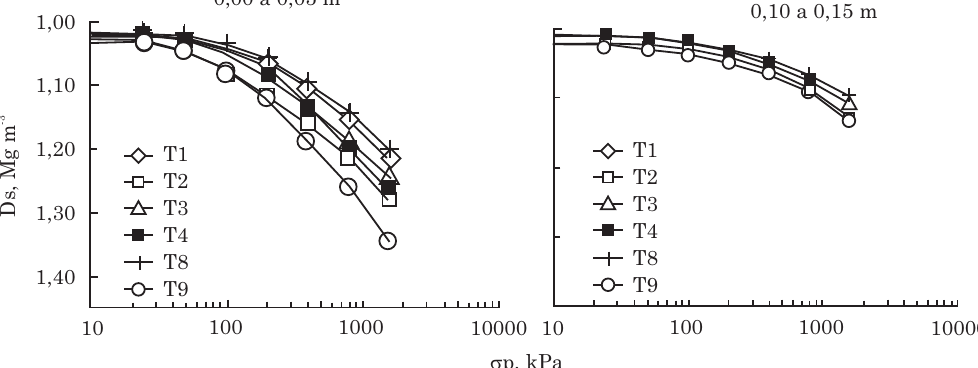
Figura 1. Curvas de compressão normalizadas relacionando a densidade do solo (Ds) em função da pressão aplicada ( σσσσσ p) de um solo construído sob diferentes plantas de cobertura, sem plantas de cobertura e um solo natural nas camadas de 0,00-0,05 e 0,10-0,15 m, em área de mineração de carvão. T1: solo construído sob Capim Vaquero; T2: solo construído sob Brizanta; T3: solo construído sob Tanzânia; T4: solo construído sob Humidícola; T8: solo construído sem plantas de cobertura; e T9: solo natural sob vegetação Quadro 3. Pressão de preconsolidação ( σσσσσ p), índice de compressão (IC), grau de compactação a 200 kPa (GC200), grau de compactação a 1.600 kPa (GC1600), grau de compactação na pressão de preconsolidação (GC σσσσσ p) e densidade na pressão de preconsolidação (Ds σσσσσ p) de um solo construído sob diferentes plantas de cobertura, sem plantas de cobertura e um solo natural nas camadas de 0,00-0,05 e 0,10-0,15 m em área de mineração de carvão